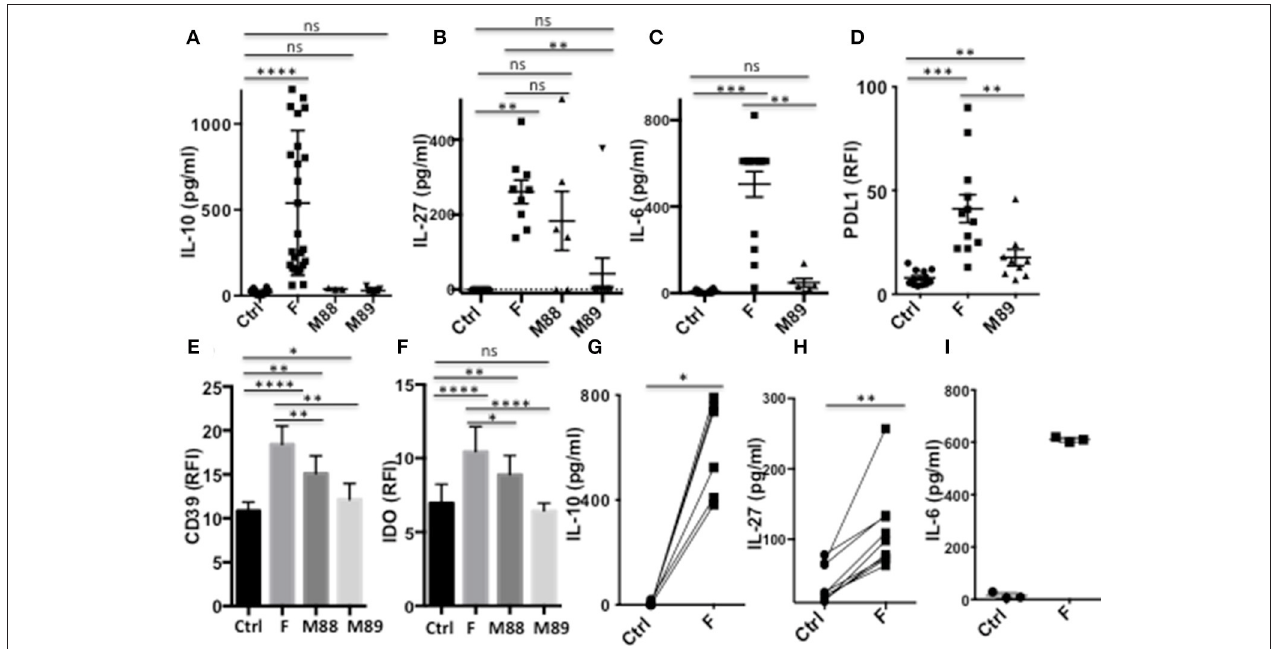
FIGURE 2 | DC exposure to F. prausnitzii promotes the production of immunoregulatory molecules. (A) : IL-10 (Ctrl and F n = 26, M88 n = 3, M89 n = 9), (B): IL-27 (Ctrl, F and M89 n = 9, M88 n = 6) and (C): IL-6 (Ctrl and F n = 12, M89 n = 6) -secretion by DC exposed or not to indicated bacteria during the last 24h. (D–F) : expression of PDL-1 and CD39 ( n = 15–29) or IDO-1 ( n = 18–25) by DC exposed or not to indicated bacteria for the last 24 or 48h. (G–I) : IL-10 ( n = 6), IL-27 ( n = 9), and IL-6 ( n = 3) secretion by myeloid DC maintained for 24h in culture with or without F. prausnitzii . Results as mean ± sem. Wilcoxon test. * p < 0.05, ** p < 0.005, *** p < 0.0005, **** p <